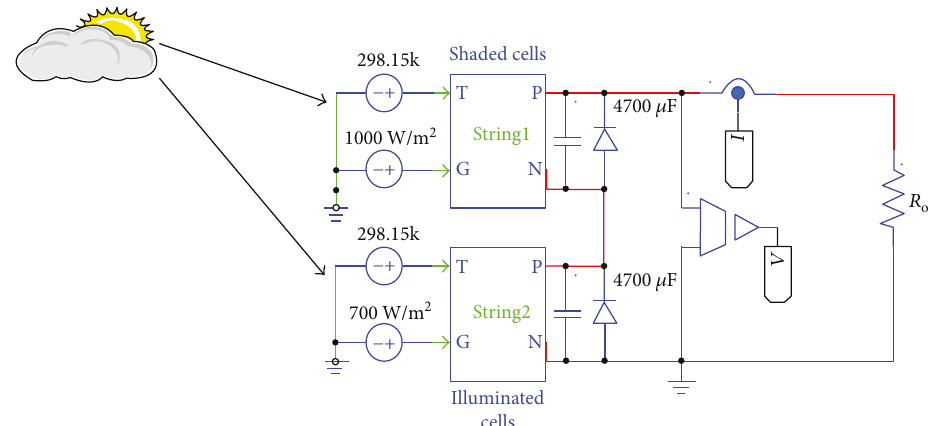
Figure 11: PV panel under nonuniform